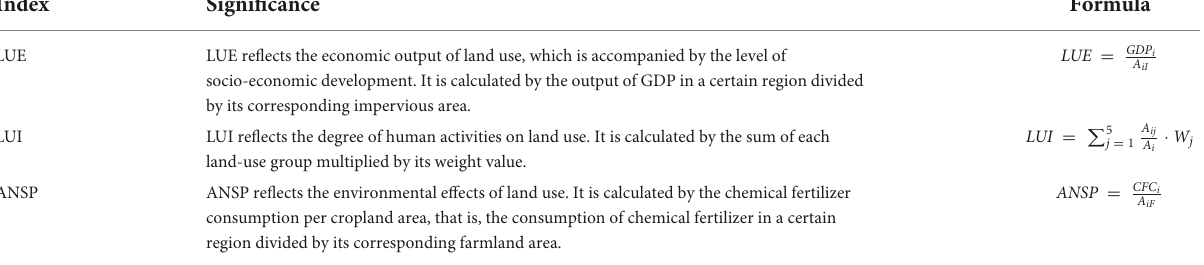
TABLE 2 Description of land-use recessive morphology index.